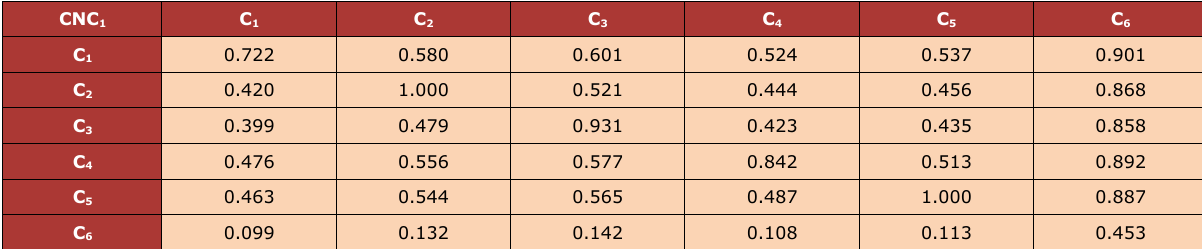
Table 10. Pair-wise comparison of criteria with respect to A